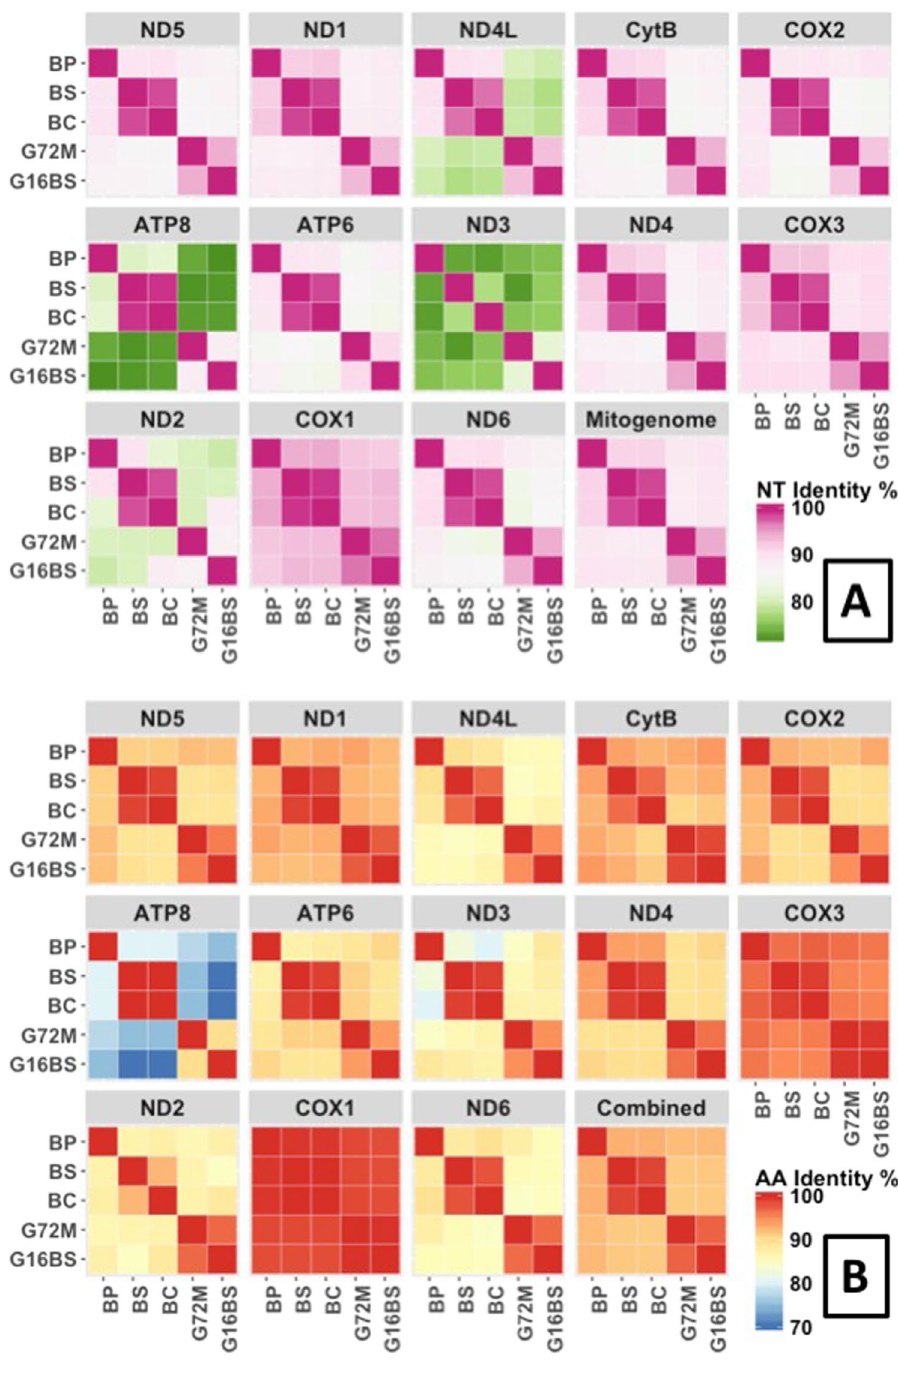
Figure 3. Heat maps showing pairwise comparison of 13 PCGs and complete mitogenome at the nt level ( A ) and gene products of all 13 PCG combined at the aa level ( B